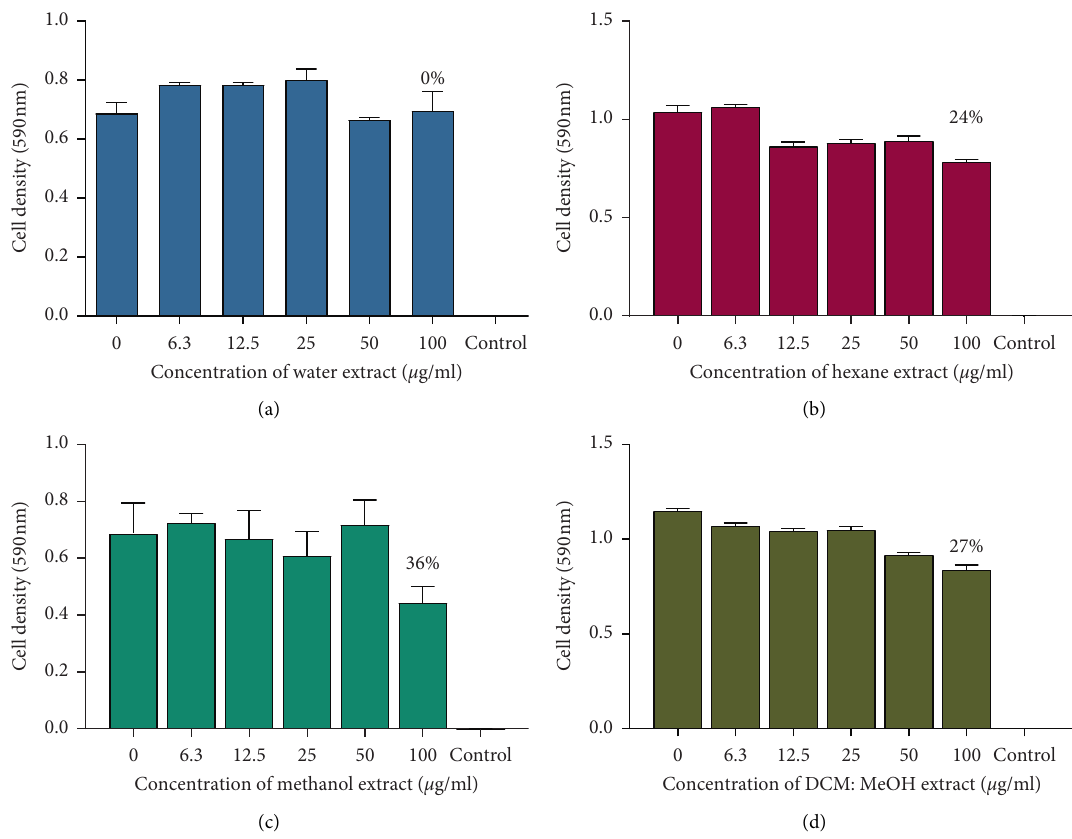
Figure 7: The effects of extracts of pods of P. thonningii against C. krusei : (a) effect of water extract, (b) effect of hexane extract, (c) effect of the methanol extract, and (d) effect of ethyl acetate extract. Concentrations of extract ranged from 6.3 μ g/mL to 100 μ g/mL. Values are in mean cell density at 590nm wavelength ± the standard deviation. N �